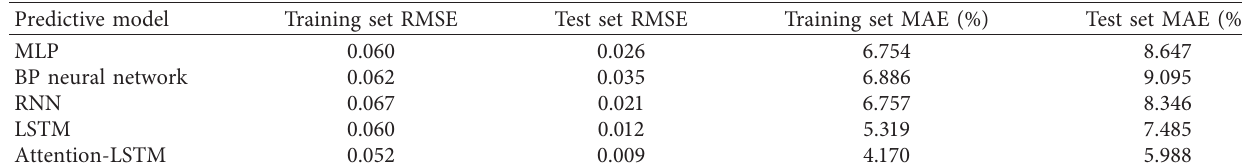
Figure 11: Multiple model prediction effect diagram. (a) MLP. (b) BP neural network. (c) RNN. (d) LSTM. Table 6: Errors in different prediction